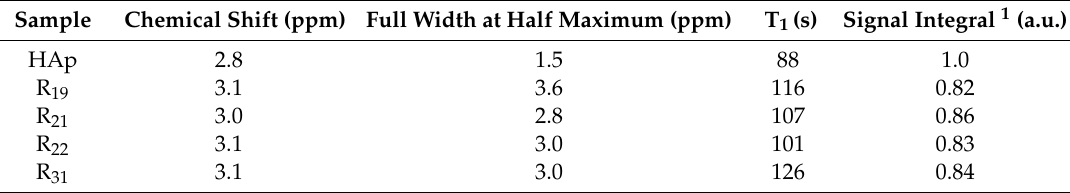
Table 2. Summary of the NMR parameters of the 31 P spectra of selected human dentin samples. HAp: